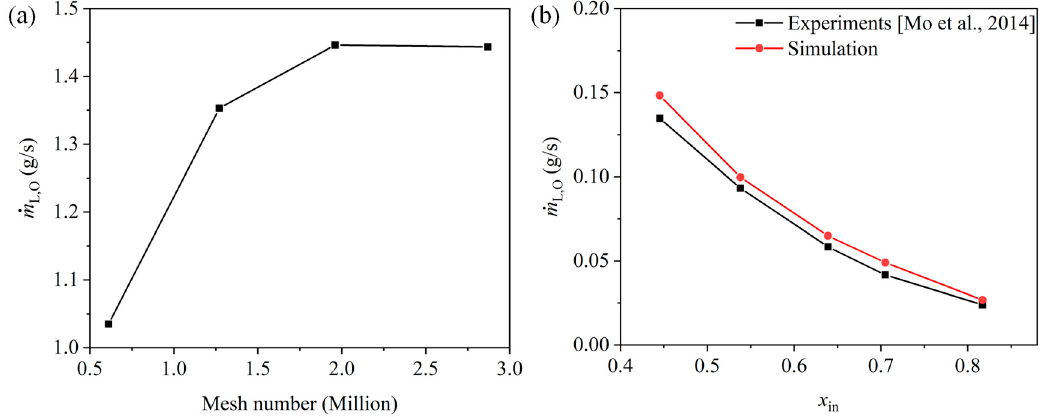
Figure 3. ( a ) Mesh-sensitive test; ( b ) model validation